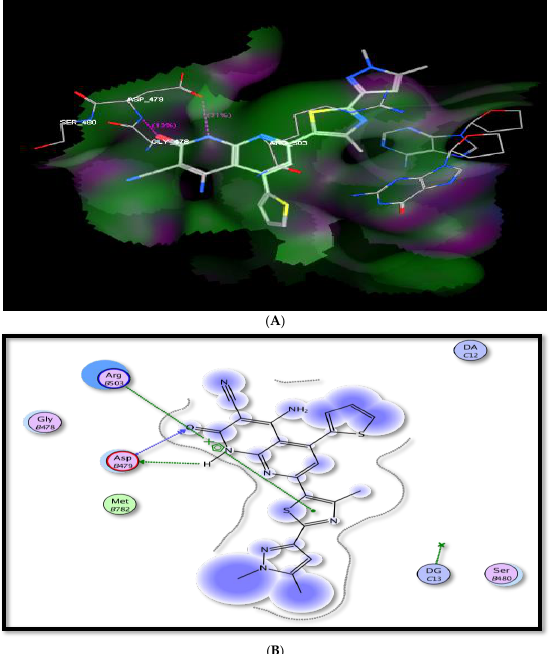
Figure 3. The suggested binding mode of compound 7 within topoisomerase II. ( A ) 3D binding mode within the active site. ( B ) 2D binding mode within topoisomerase II. On the other hand, compound 6 performed two types of interactions with the topoi- somerase II active site. One is hydrophobic binding of the thiophen moiety with DGC13, and the other binding involves hydrogen bond interactions as follows: (i) AspB479 with NH 2 , and (ii) LysB456 with CN (Figure 4).